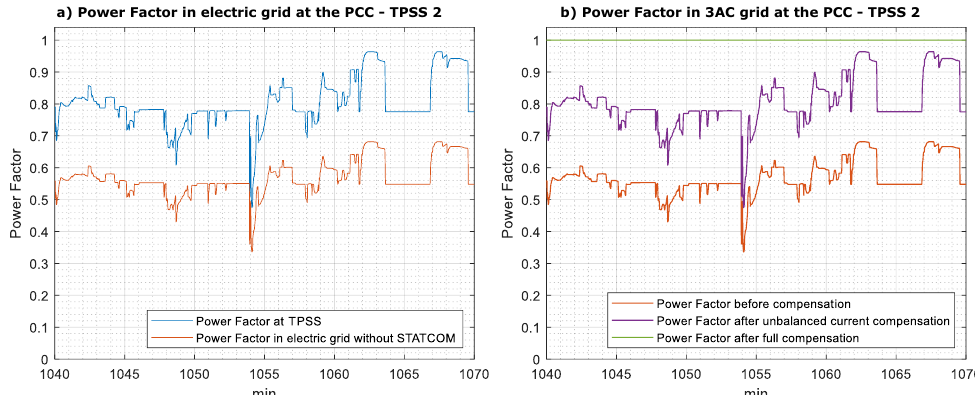
Figure 22. Power factor in the three-phase grid when TPSS 2 is operating in normal mode: ( a ) without Balancer compensation; ( b ) with Balancer compensation.